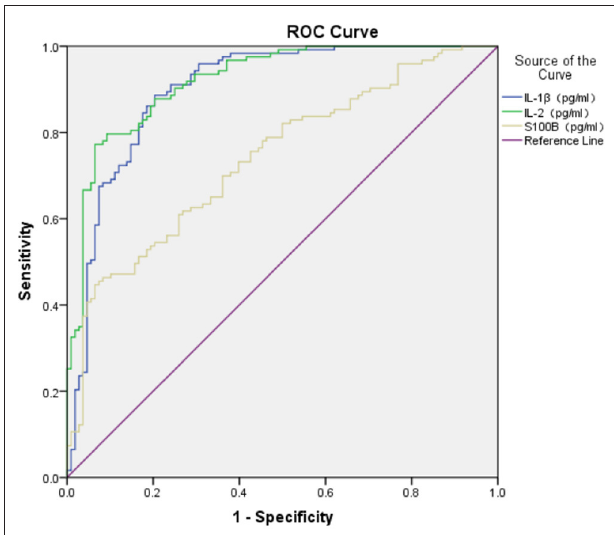
FIGURE 1 | ROC of S100B, IL-1 β , IL-2 in diagnosis of GAD.